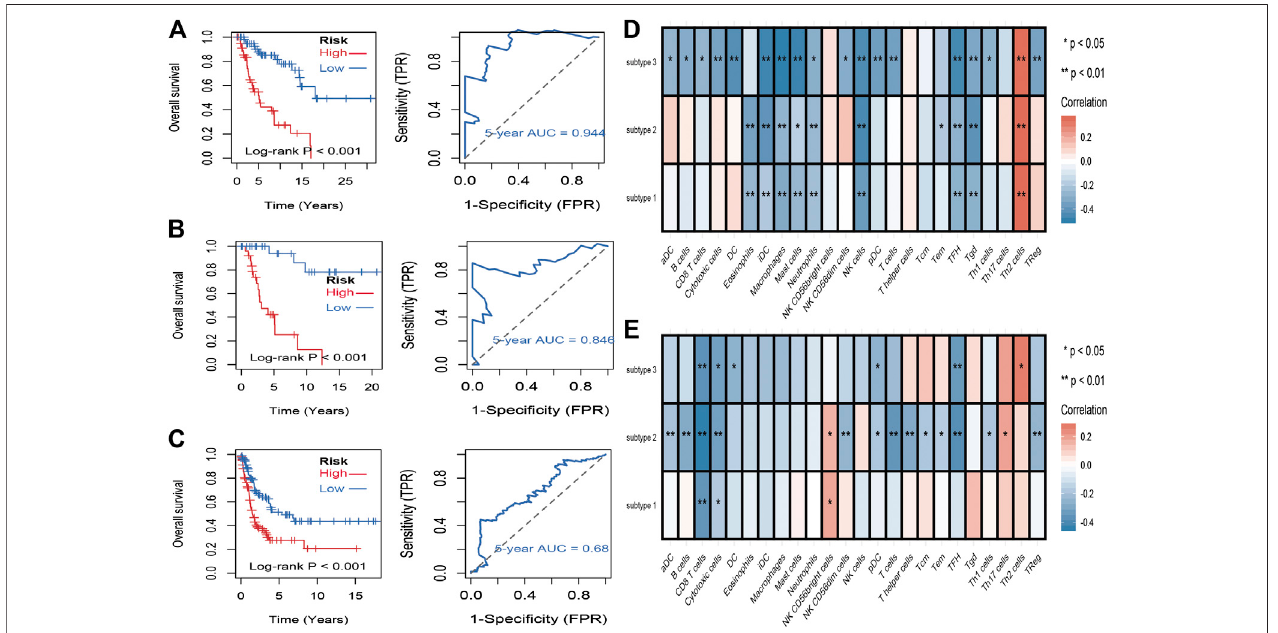
FIGURE 5 | Identi fi cation and validation of stemness-related genes feature for survival prediction. (A) : Kaplan – Meier analysis of 11 mRNAsi-related genes ’ signature and 5 years of the receiver operating characteristic (ROC) curve in training dataset. (B) : Kaplan – Meier analysis of 11 mRNAsi-related genes ’ signature and 5 years of the receiver operating characteristic (ROC) curve in validation dataset. (C) : Kaplan – Meier analysis of 11 mRNAsi-related genes ’ signature and 5 years of the receiver operating characteristic (ROC) curve in GSE65904 dataset. (D) : correlations between the mRNAsi and the subsets of tumor-in fi ltrating immune cells estimated by “ ssGSEA ” method. ( F ) : correlations between the mDNAsi and the subsets of tumor-in fi ltrating immune cells estimated by “ ssGSEA ” method.